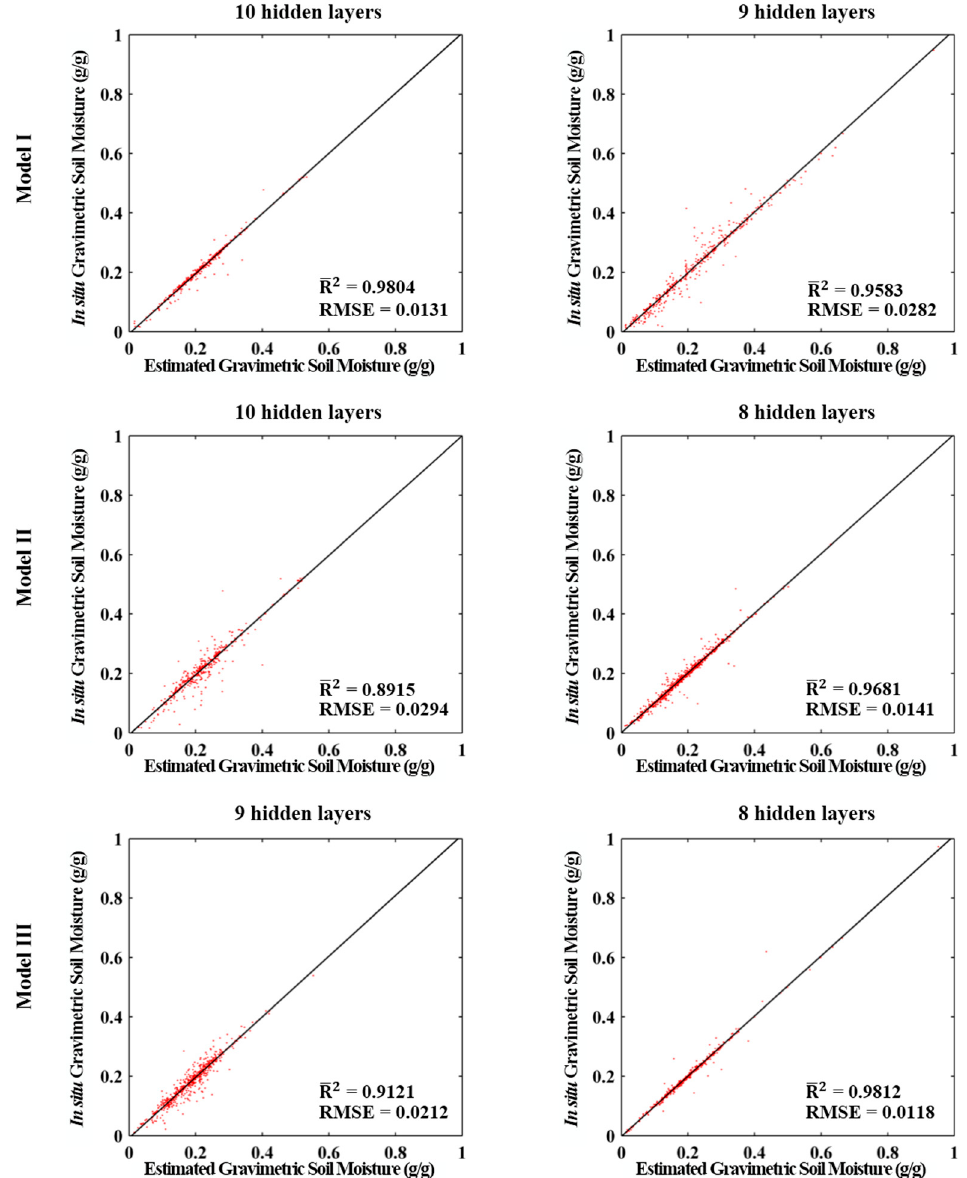
Figure 4. Comparison between in situ soil moisture and estimated soil moisture as obtained by the optimal versions of Model I, Model II and Model III.